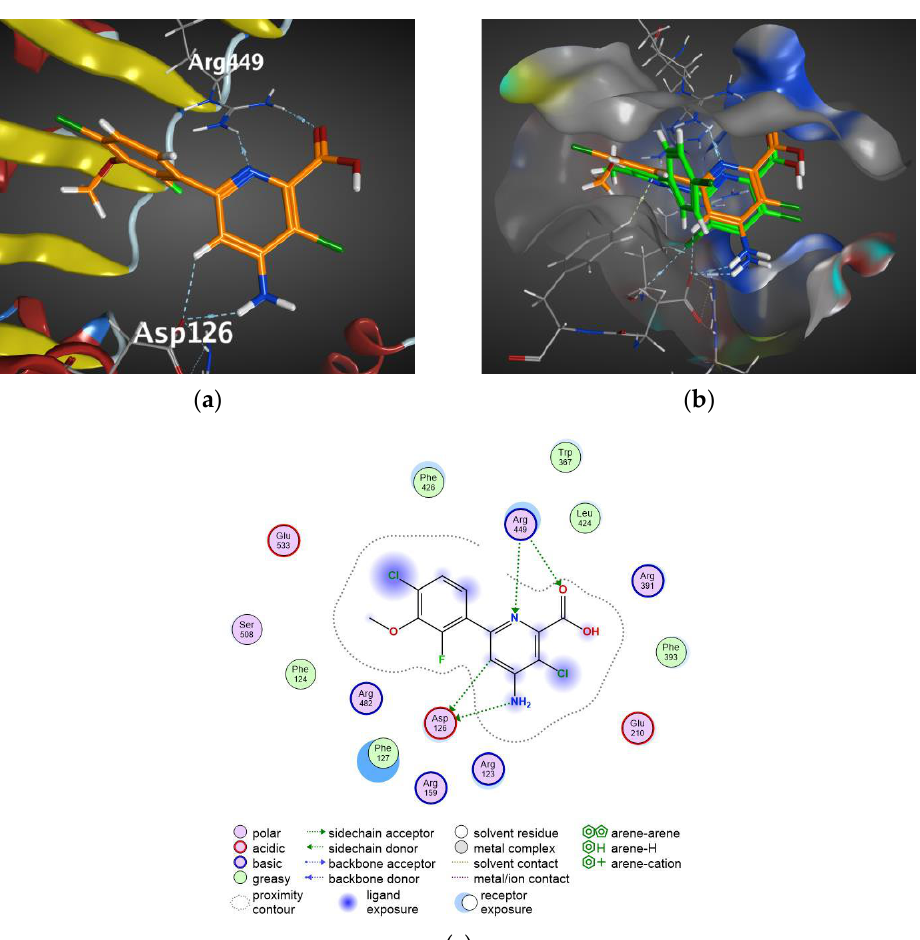
Figure 5. ( a ) Docking arrangements of halauxifen to AFB5. ( b ) Superposition diagram of compound V-7 and halauxifen docking arrangements to AFB5. White sticks represent hydrogen atoms, red sticks represent oxygen atoms, blue sticks represent nitrogen atoms and dark green sticks represent chlorine atoms. ( c ) Two-dimensional interaction of halauxifen to AFB5.